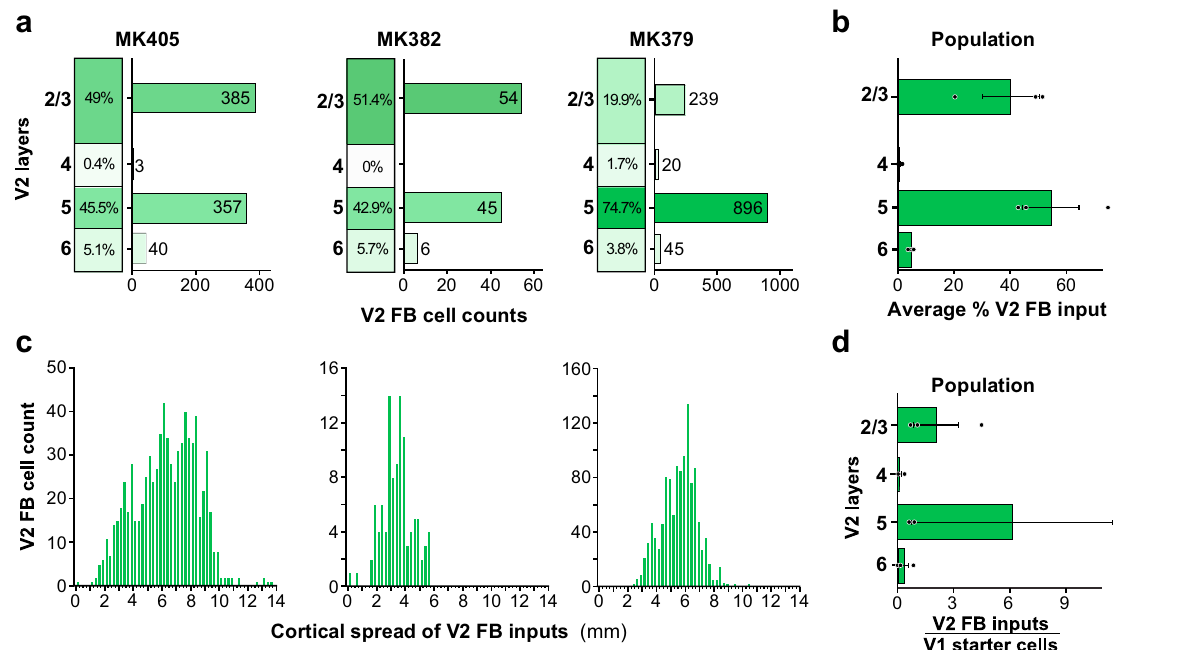
Fig. 5 Laminar and tangential distribution of monosynaptic V2 FB inputs to V1 → V2 cells. a Percent and number of GFP-labeled cells across V2 layers for each of the three cases. b Population average percent ± s.e.m. of GFP-labeled cells across V2 layers ( n = 2090 cells in three independent animals). c Distribution of GFP-labeled cells across the tangential domain of V2 pooled across layers. Other conventions as in Fig. 4. d Population average ratio of V2 input cells in each layer to the total number of V1 → V2 starter cells (pooled across layers; n = 3 independent animals). Error bars: